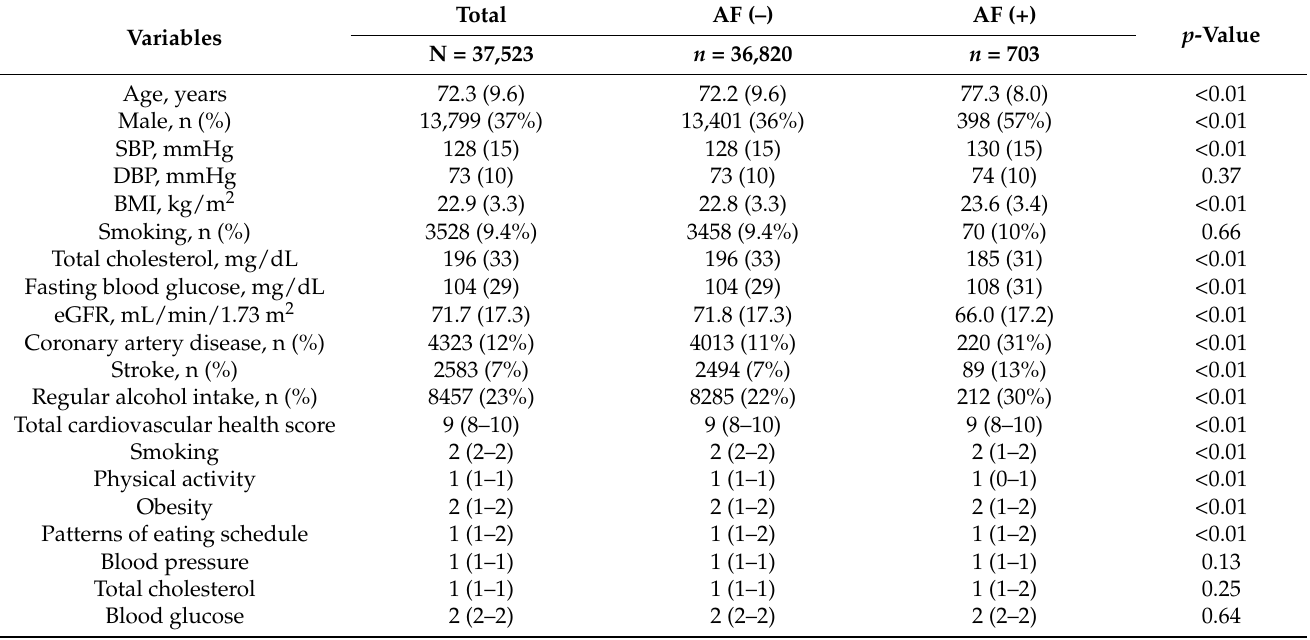
Table 1. Basic characteristics of the study population. Regular alcohol intake meant drinking every day. SBP, systolic blood pressure; DBP, diastolic blood pressure; BMI, body mass index; eGFR, estimated glomerular filtration